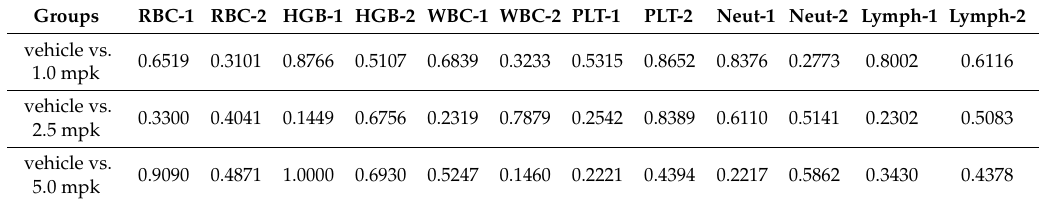
Table 2. The p value in the unpaired t -test between the vehicle and ADC treatment groups. Groups